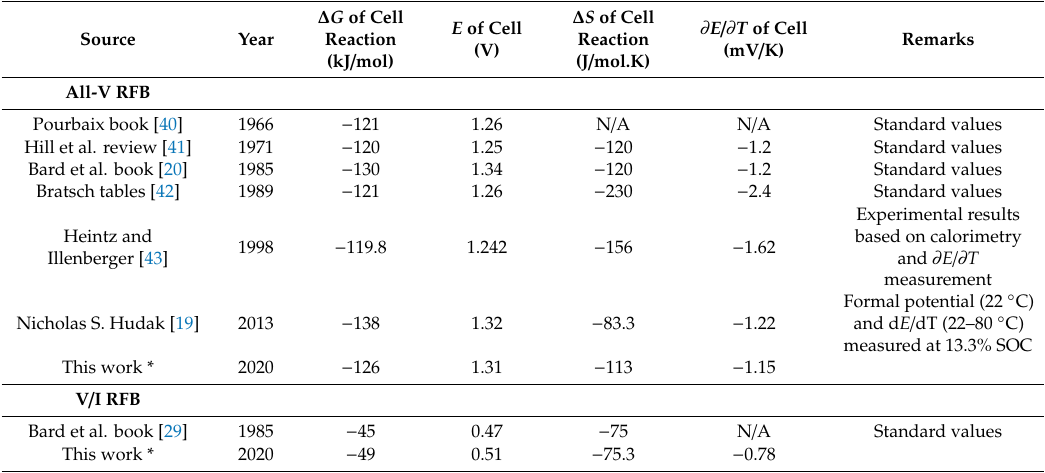
Table 3. Thermodynamic quantities for the cell reactions of the all-V RFB and V / I RFB by the real-time monitoring of the ITI